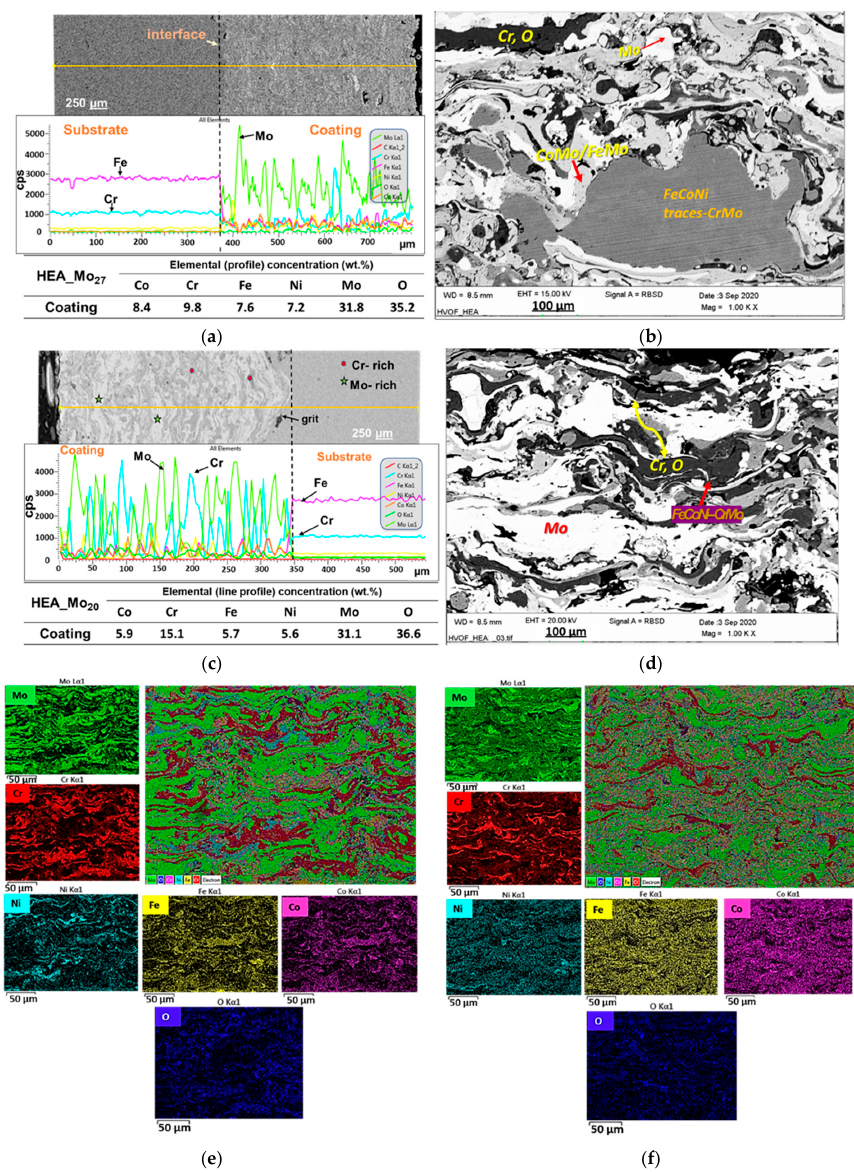
Figure 2. SEM ( a , c ) and BSE micrographs ( b , d ) of the cross-sections of the as-sprayed HVOF- HEA_Mo 27 ( a , b , e ) and HVOF-HEA_Mo 20 coatings ( c , d , f ) and the corresponding EDX line scans ( a , c ) and maps ( e , f